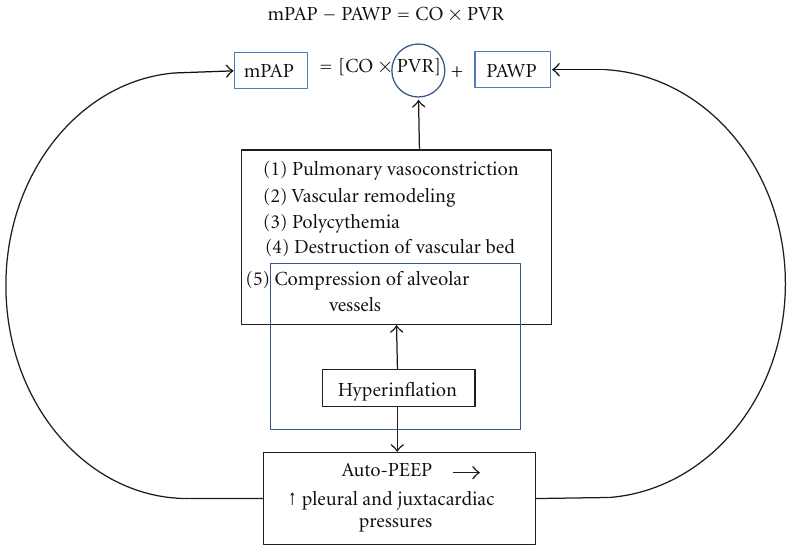
Figure 1: Pathophysiology of PH in COPD. mPAP: mean pulmonary artery pressure, PAWP: pulmonary artery wedge pressure, CO: cardiac output, PVR: pulmonary vascular resistance, PEEP: positive end-expiratory pressure.